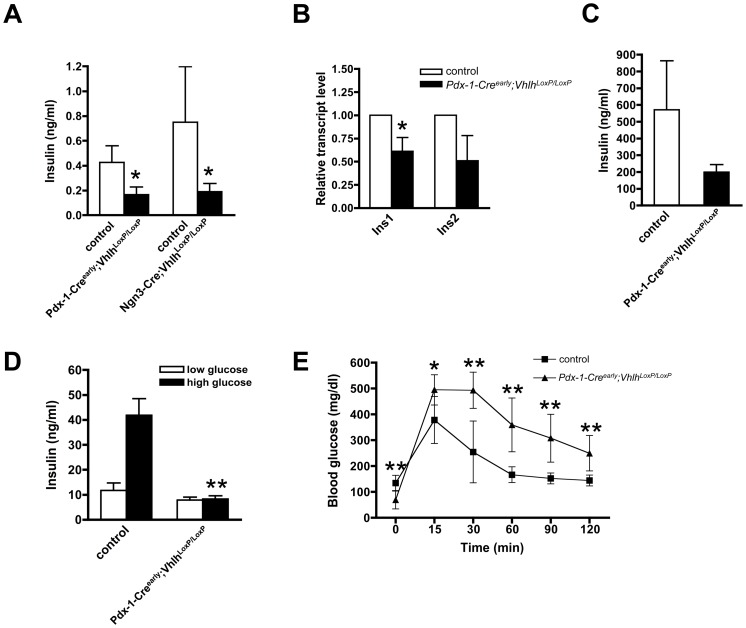
VHL inactivation impairs insulin secretion but does not result in hyperinsulinemia.
A. Plasma insulin under fed conditions is reduced in Pdx-1-Creearly;VhlhLoxP/LoxP (n = 3) and Ngn3-Cre;VhlhLoxP/LoxP (n = 5) animals as compared to control animals (n of 4 and 5, respectively). *p<0.05. B. Transcript analysis in islets isolated from p15 pups (n = 3) by quantitative PCR reveals a moderate yet significant reduction in the Ins1 transcript and a similar trend in Ins2 transcript level in Pdx-1-Creearly;VhlhLoxP/LoxP animals (black bars). C. Total insulin content appears reduced in islets isolated from Pdx-1-Creearly;VhlhLoxP/LoxP (black bars, n = 4) versus control (open bars, n = 4) animals. D. In an in vitro secretion assay, islets isolated from control animals (n = 4) respond appropriately to a high glucose challenge, while Pdx-1-Creearly;VhlhLoxP/LoxP islets (n = 4) are severely impaired in glucose stimulated insulin secretion. **p<0.005. E. An IPGTT on animals (p19–20) reveals that the Pdx-1-Creearly;VhlhLoxP/LoxP animals (n = 8) are impaired in clearing glucose from the blood, while the control cohort (n = 16) normalizes blood glucose by the end of two hours. *p<0.05, **p<0.005. Error bars represent standard deviation.